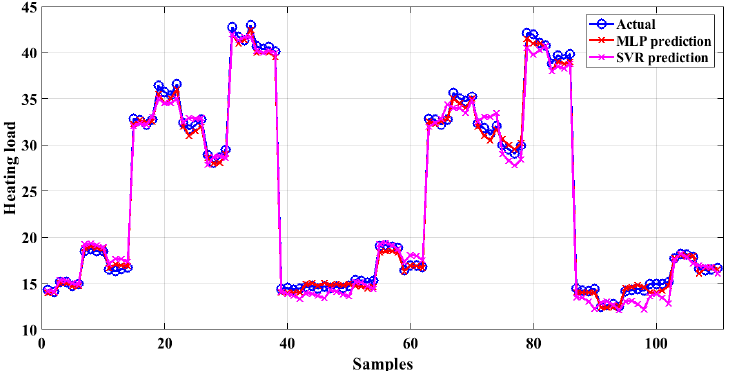
Figure 6. SVR testing error in the for histogram; ( a ) heating load; ( b ) cooling load.